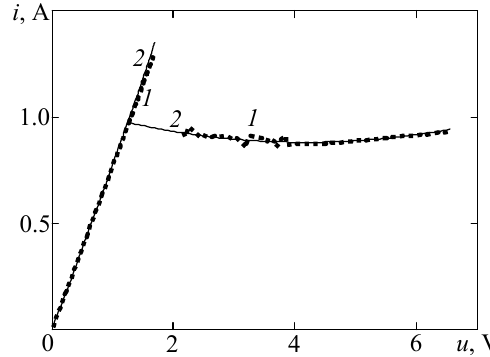
Fig. 5. Experimentally measured I-V characteristic of the Gunn diode 3A702 ( 1 ) in comparison with the model ( 2 ).